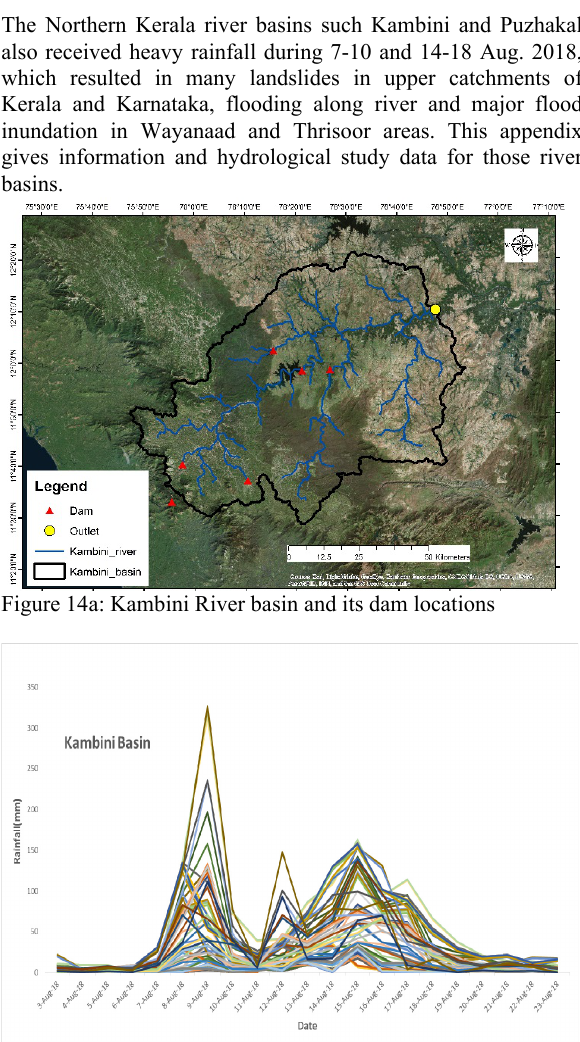
Figure 14b: Daily rainfall from IMD data for various sub- watersheds of Kambini river basin.